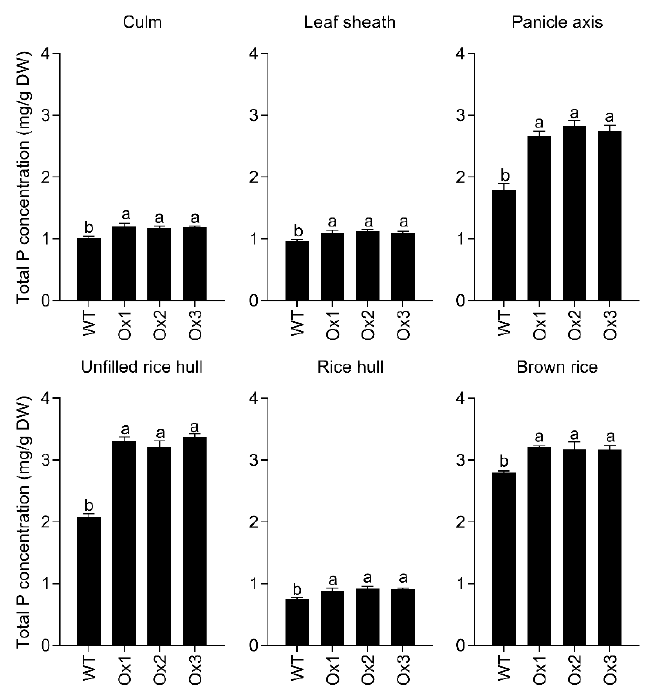
Figure 6. Overexpression of OsPHT1;4 elevates total P concentration. WT and Ox1–Ox3 seedlings (10 days old) were grown to maturity in the field for 20 weeks. Various tissues indicated on the panel were harvested and the total P concentration was determined. Values are means ± SE ( n = 5). Different letters above the bars indicate significant differences ( p < 0.05, one-way ANOVA).